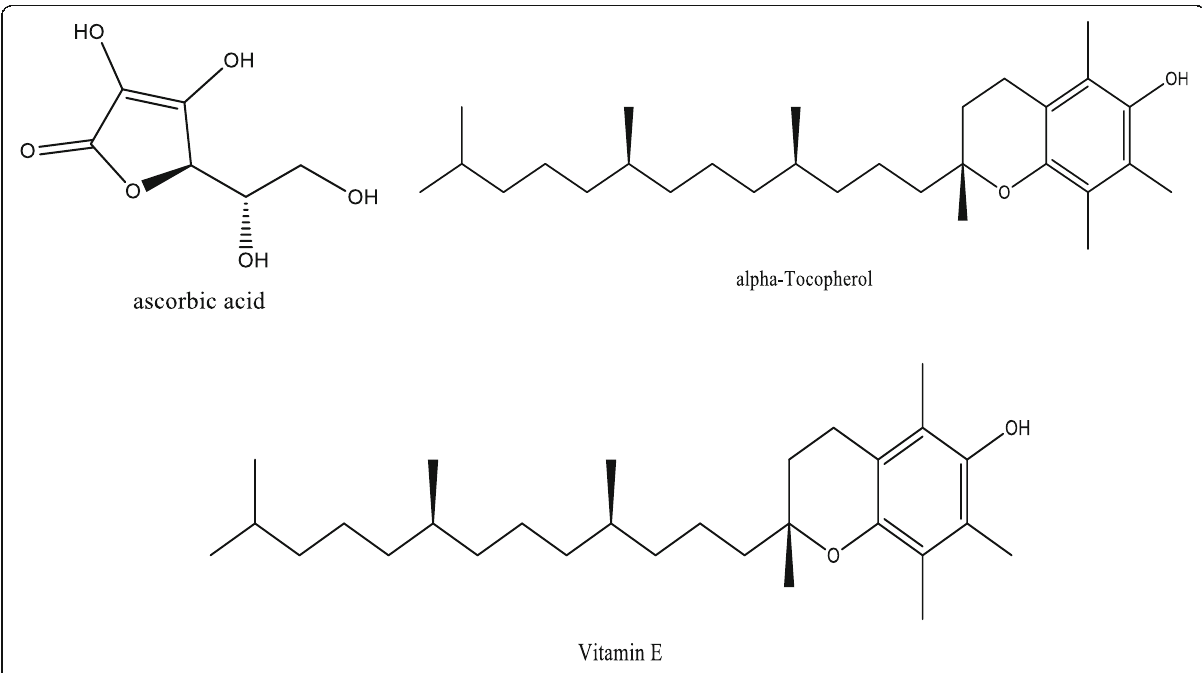
Fig. 20 Chemical structures of some vitamins isolated from A. vera and A.